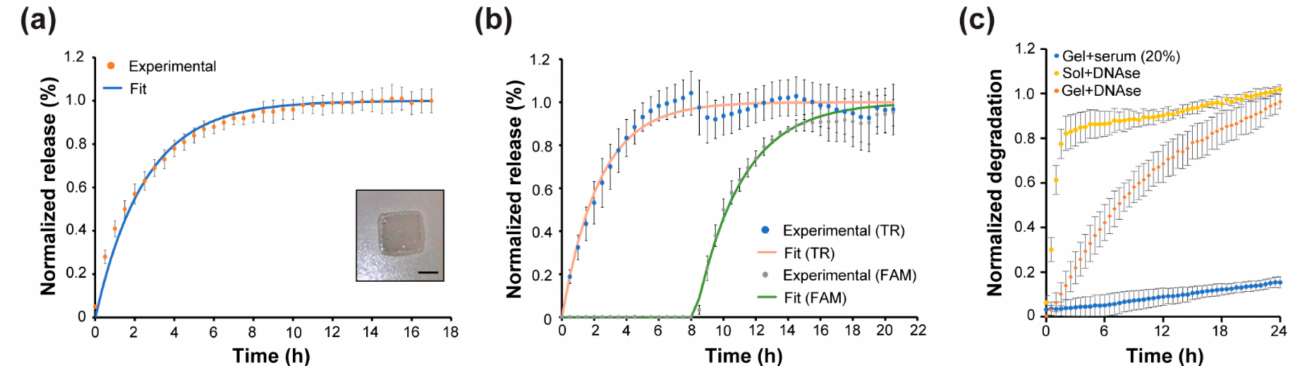
Figure 4. Controlled release within DNA-Gel hydrogel. ( a ) 4WJ-HEX release curve within DNA-Gel hydrogel. Inset shows the crosslinked gelatin hydrogel. Scale bar: 1 mm. ( b ) The sequential release of 4WJ-2FQ within in DNA-Gel hydrogel. ( c ) Stability of the 4WJ-HEX against serum in DNA-Gel hydrogel and DNase within solution and DNA-Gel hydrogel. The release was normalized against the positive control, which is the DNA motif without the